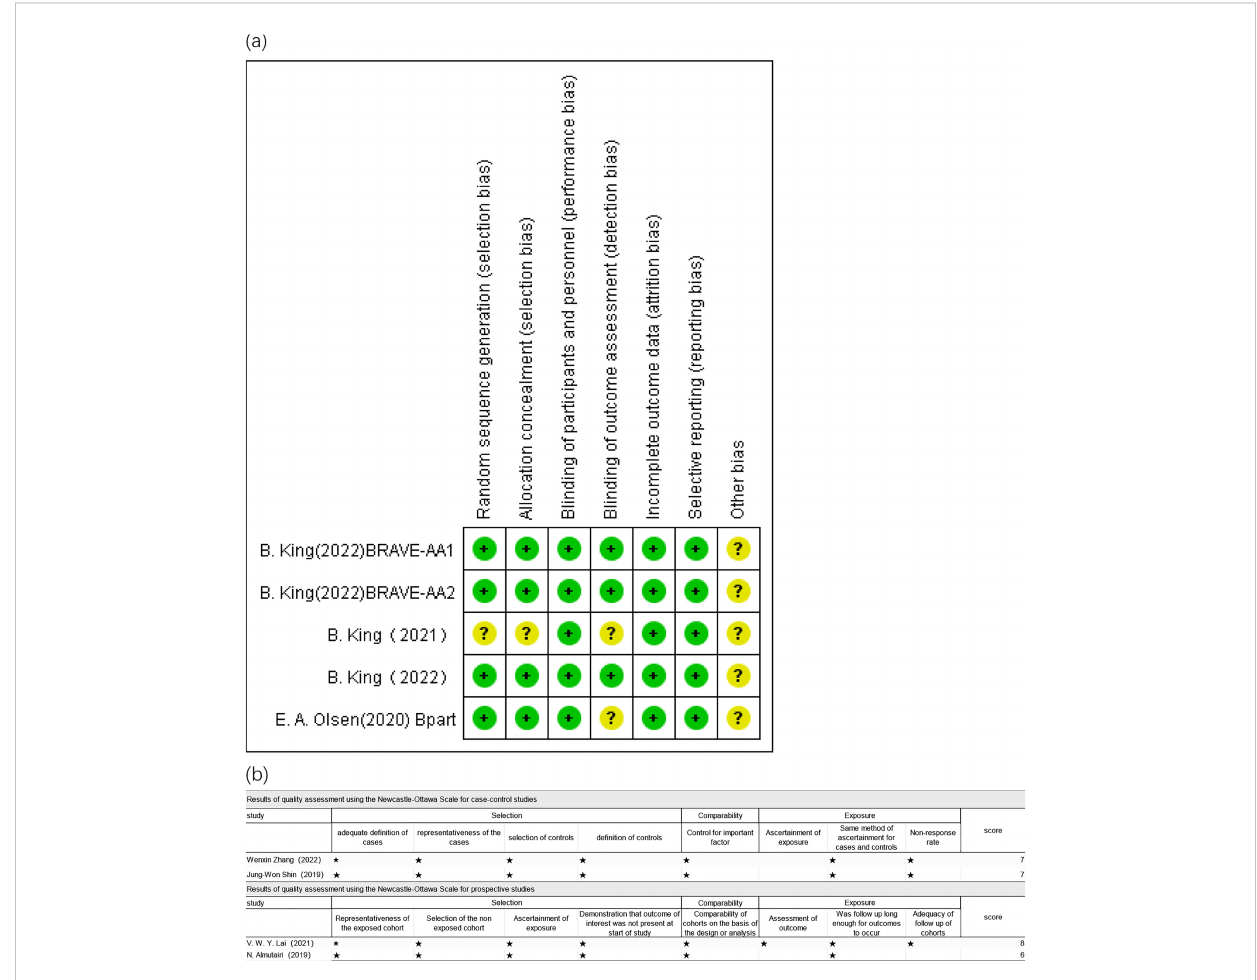
FIGURE 2 Risk of bias in (A) included RCTs and (B) included